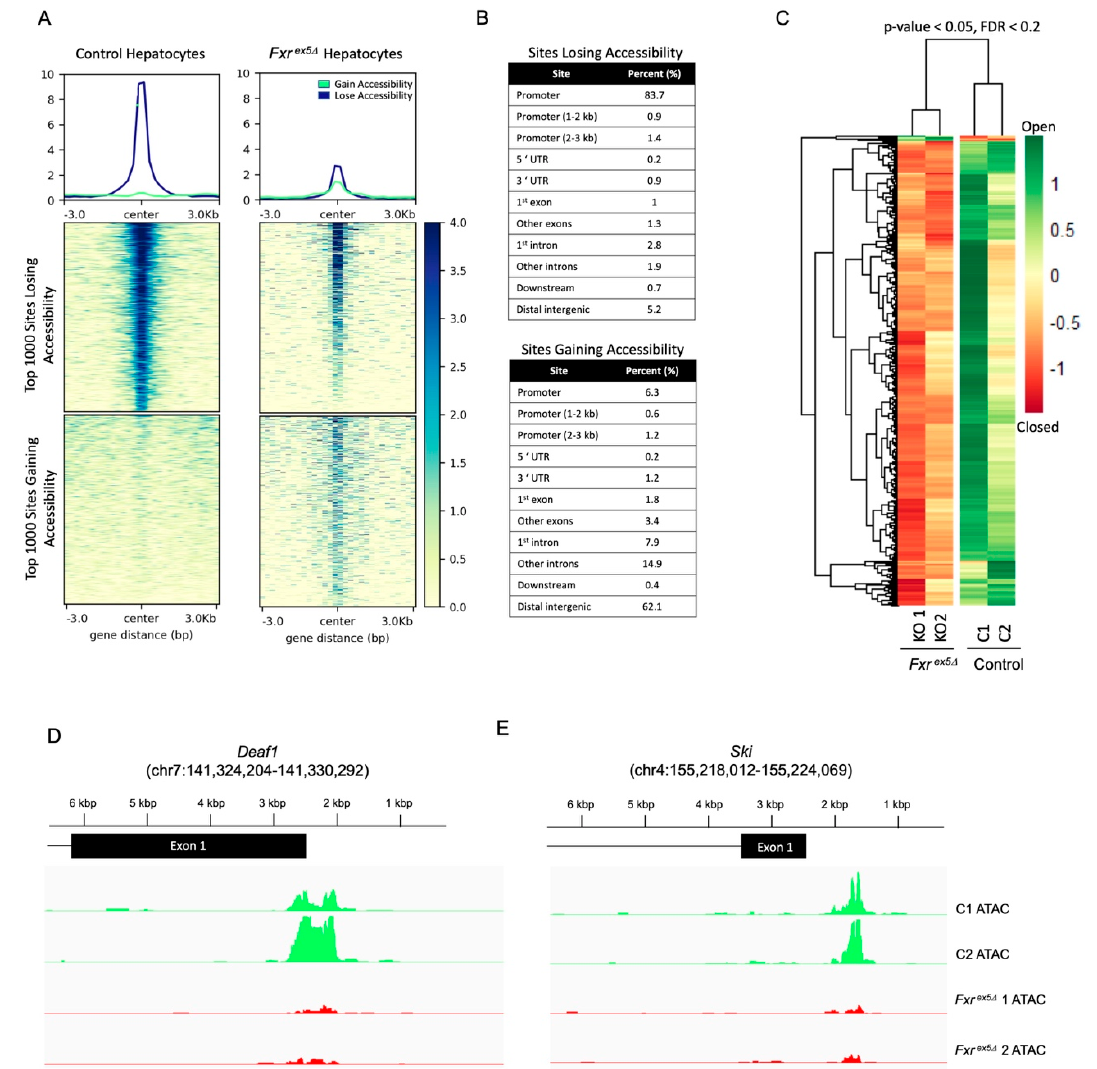
Figure 2. Global changes in chromatin accessibility in Fxr ex5 Δ hepatocytes. ( A ) ATAC-seq was performed on control and Fxr ex5 Δ hepatocytes. Heatmap of 1592 differentially accessible regions that pass the FDR cut-off of 0.2. ( B ) Table showing distribution of annotated genomic features for the top 1000 peaks with loss or gain of accessibility with Fxr ex5 Δ in hepatocytes. ( C ) Top 1000 differentially accessible normalized ATAC-Seq peaks were separated by loss or gain of accessibility. Then, heatmap of signal distribution around ATAC-Seq peak summits was generated for both control and Fxr ex5 Δ samples. ( D , E ) Genomic tracts of ATAC-seq signal in control and Fxr ex5 Δ hepatocytes at the top two differentially accessible promoters, Deaf1 ( D ) and Ski ( E ) genes.